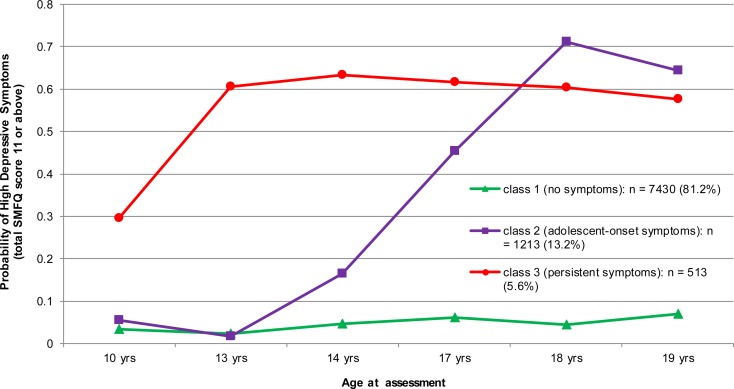
Three Class Model of Depressive Symptoms between 10 and 19 years in the ALSPAC cohort. Note: Class membership is driven by the probability of high depressive symptoms, defined as total SMFQ score 11 or above, at six follow-up points. Class 1 = consistently low symptoms at all six follow-ups (‘No symptoms’). Class 2 = symptoms low in the first two follow-ups but increase subsequently (‘Adolescent-onset symptoms’). Class 3 = consistently high symptoms at all six follow-ups (‘Persistent symptoms’).